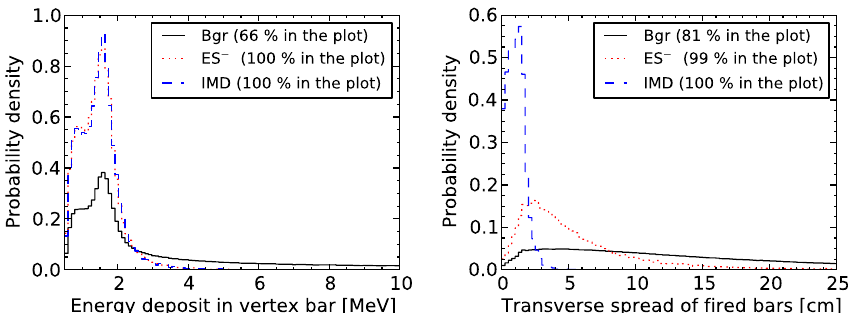
FIG. 9. Distributions of the energy deposited in the vertex bar (left) and x background (black) events in 25 GeV (cid:3) (cid:1) mode. The fraction of events contained in the plot is indicated in the legend. All distributions are normalized to a unit area. This plot shows only events for which the reconstructed vertex is in a scintillator